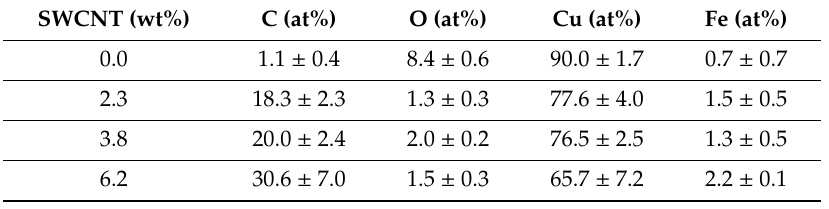
Table 2. EDX analysis of electroplated Cu–SWCNT composites electrodeposited at a bath temperature of 60 °C.